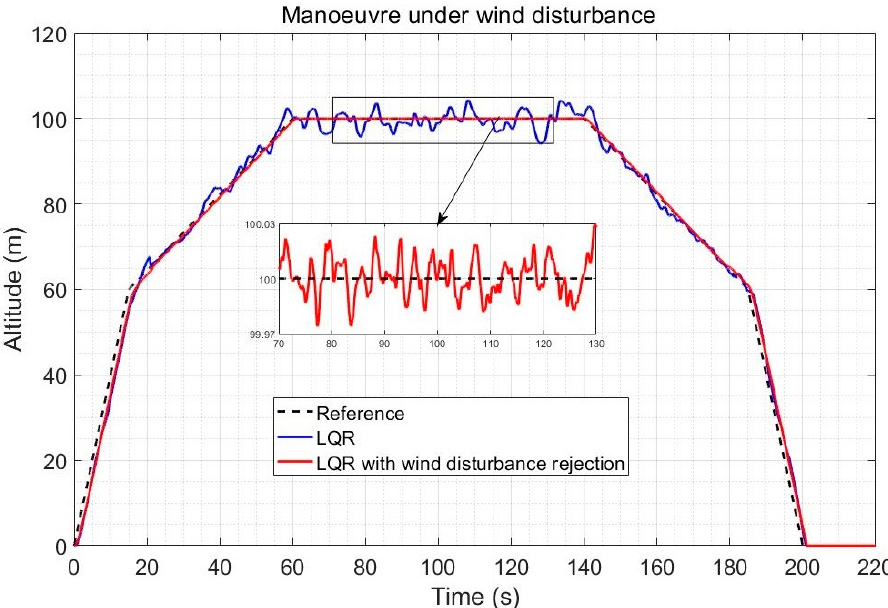
Figure 10. Altitude response comparison during a climb-cruise-land trajectory under an average wind intensity of 5 m/s. Table 2. Integrated absolute error for reference following with different perturbation observer gains and wind